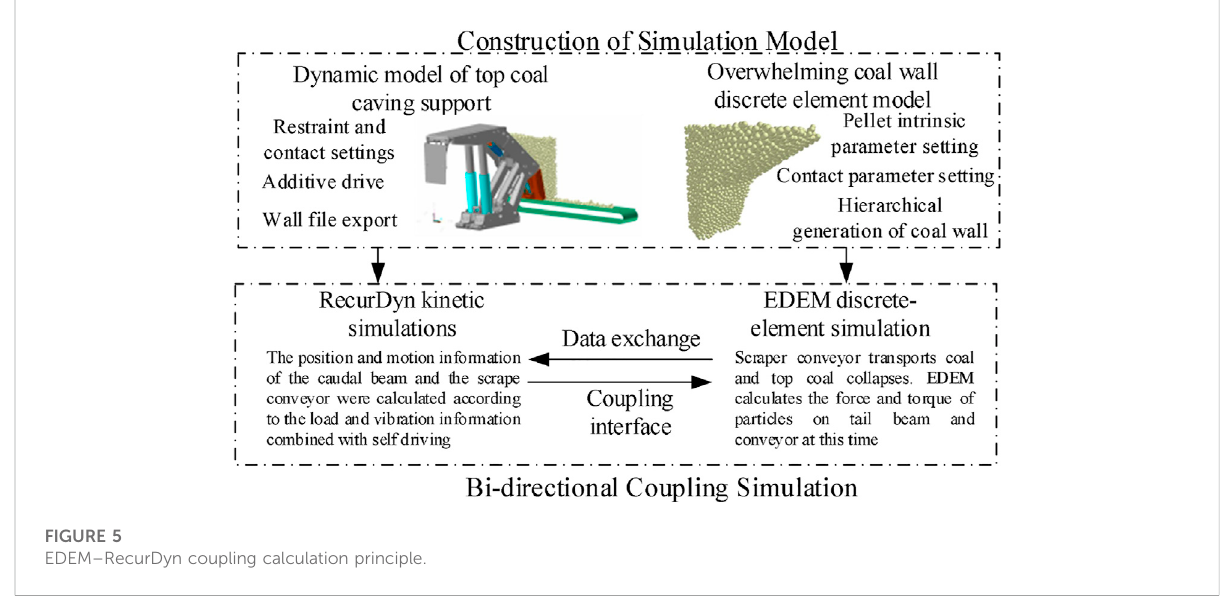
FIGURE 5 EDEM – RecurDyn coupling calculation principle.